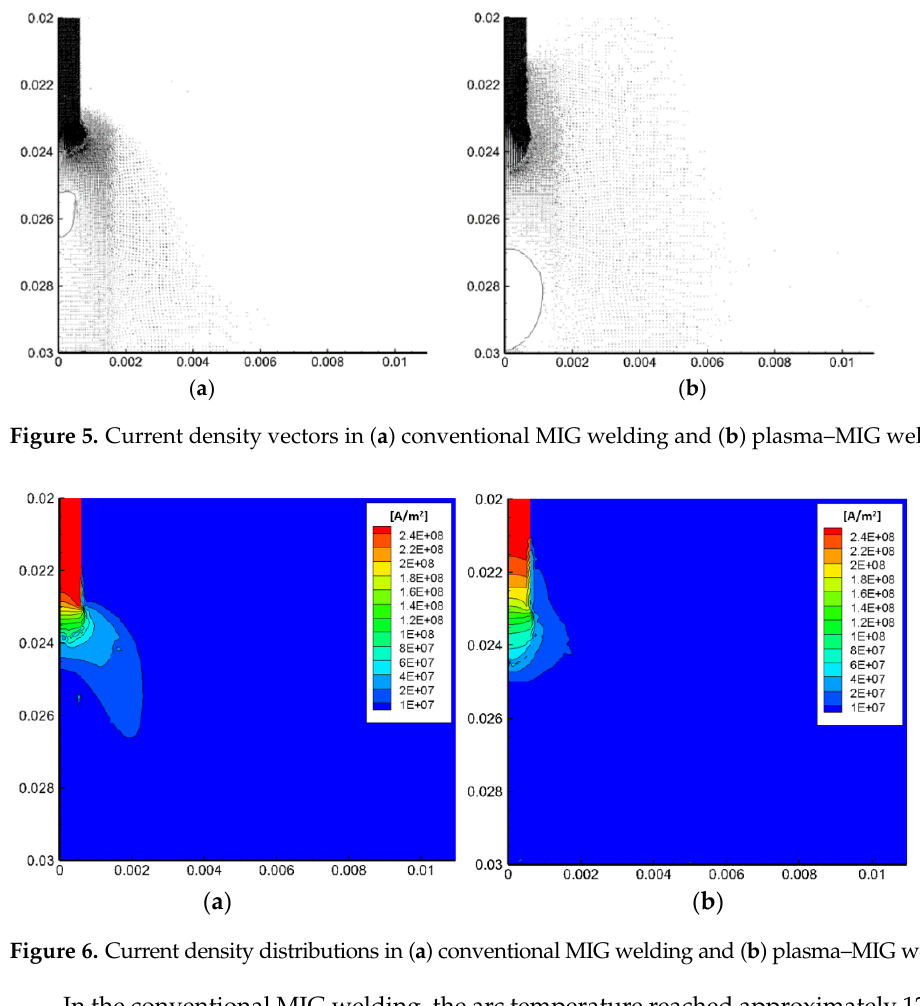
Figure 7. Dependence of electrical conductivity on temperature and metal vapor concentration.